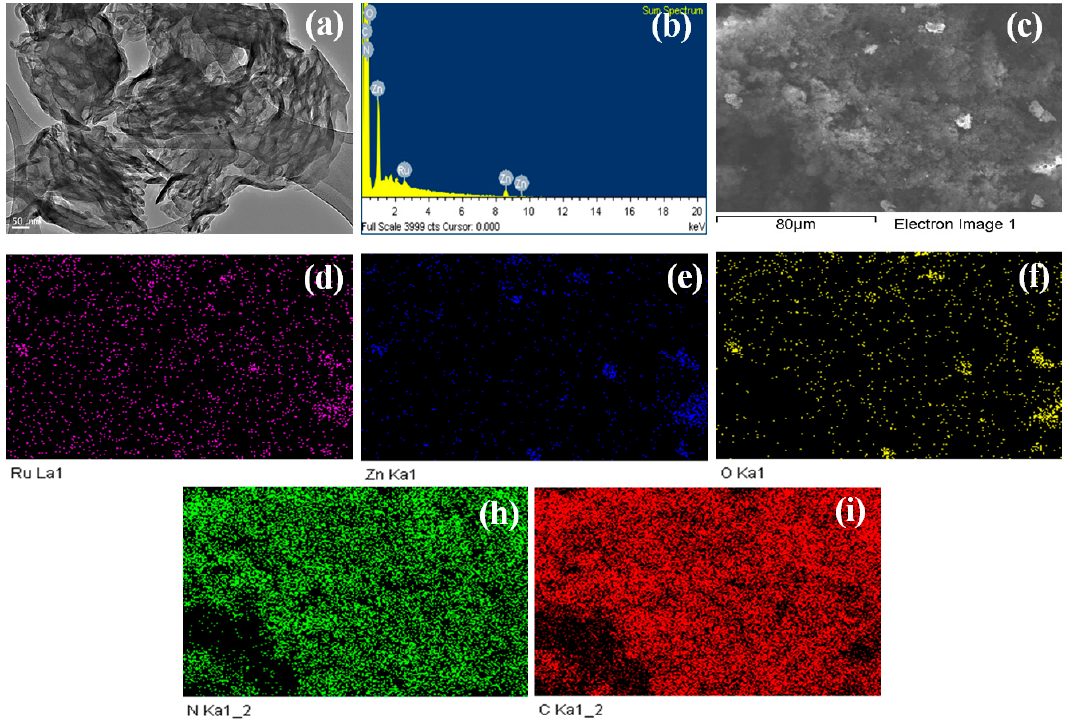
Figure 4. ( a ) TEM image, ( b ) EDX and ( c – f,h,i ) elemental mapping of nanocomposite.